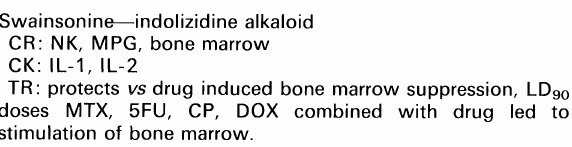
Table 11. Current applications of biological response modifiers Swainsonineindolizidine alkaloid CR: NK, MPG, bone marrow CK: IL-1, IL-2 TR: protects vs drug induced bone marrow suppression, LD9o doses MTX, 5FU, CP, DOX combined with drug led to stimulation of bone marrow. Thymosin--thymosin fraction 5 + thymosin alpha 1. TR: treatment of chronic hepatitis B (phase II). Patients (20)